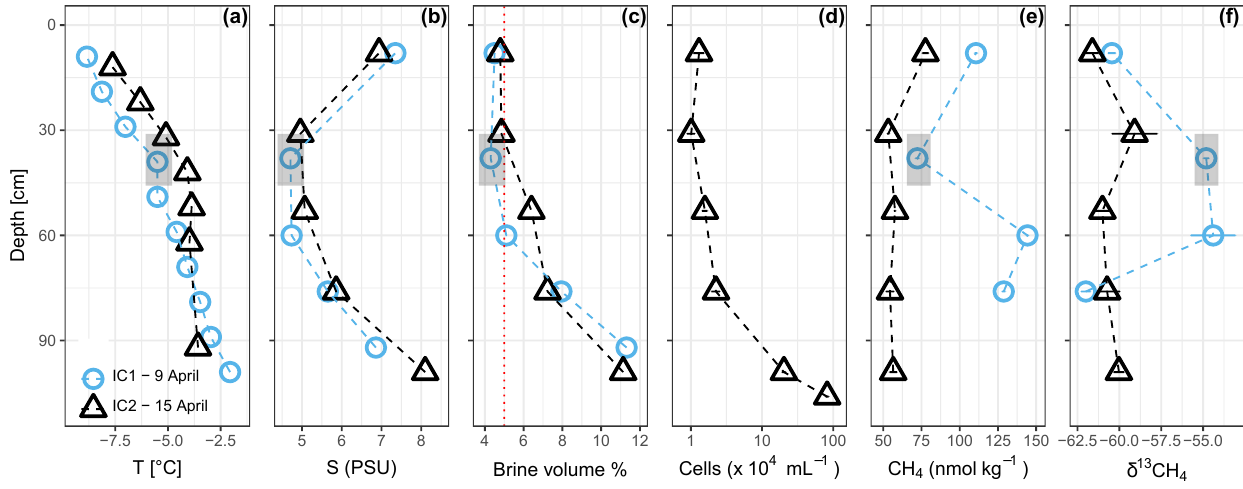
Figure 2. Sea ice temperature (a) , bulk salinity (b) , brine volume fraction (c) , prokaryotic cells mL − 1 sea ice (for IC2 only) (d) , methane concentration (e) , and stable isotope ratios (f) . The vertical red dotted line in (c) shows a brine volume fraction of 5%, the threshold for permeability (Golden et al., 1998). IC1 had sediment included into the ice matrix at depths 30–46cm, indicated by the gray box.